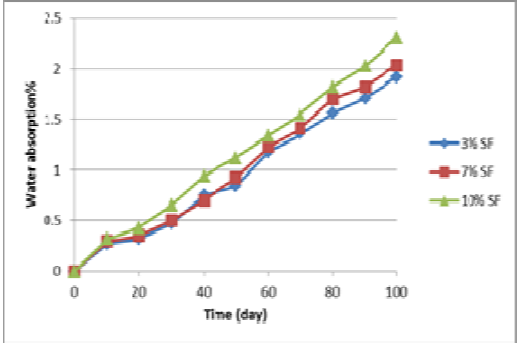
Fig. 11. Effect of sunflower husk particles on water absorption.